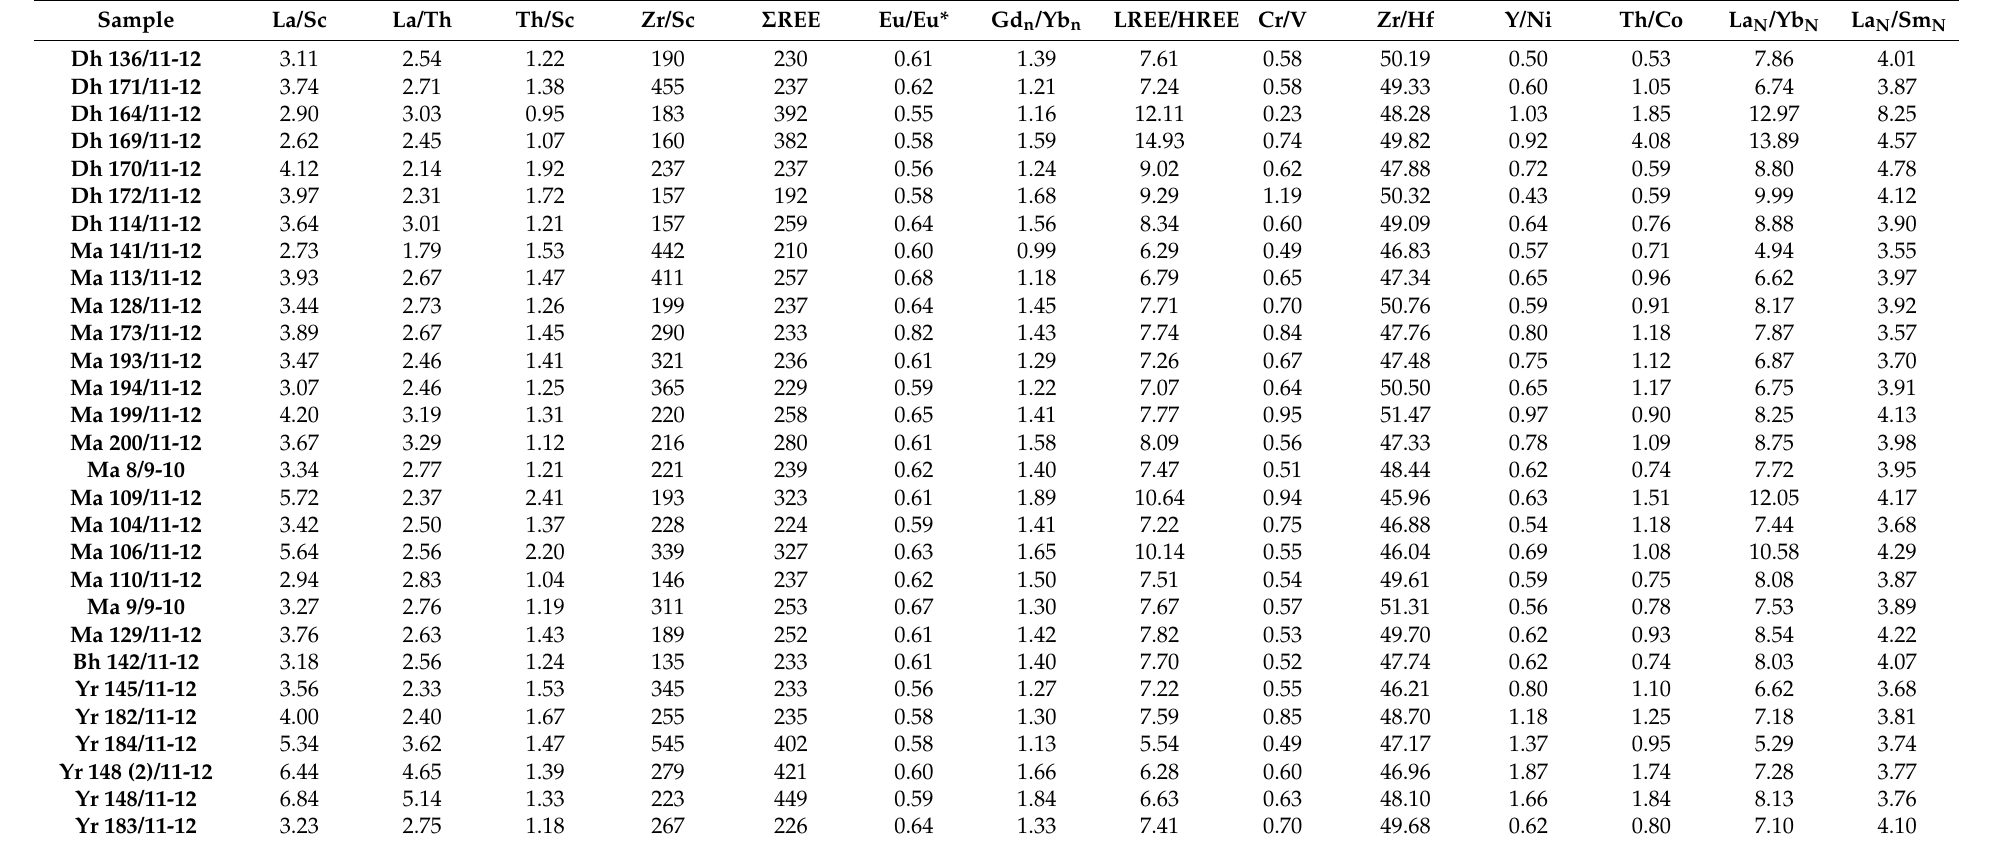
Table 7. Ratios of trace element concentration in the Mesozoic mudstone